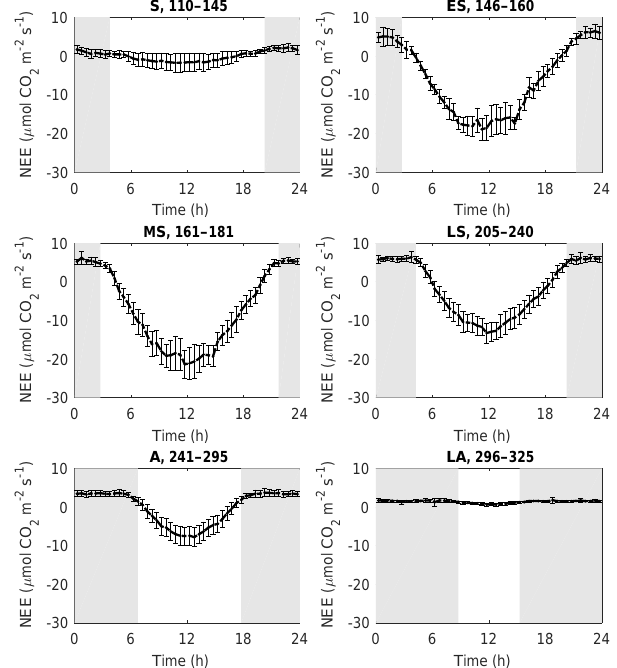
Figure 4. Diurnal cycle of half-hour mean net ecosystem exchange of CO 2 (NEE, µmol CO 2 m − 2 s − 1 ) from the reed canary grass crop from six distinct periods during the April to November 2011. Grey areas indicate the moment of sunrise and sunset, and the vertical bars indicate ± 1 SD of the